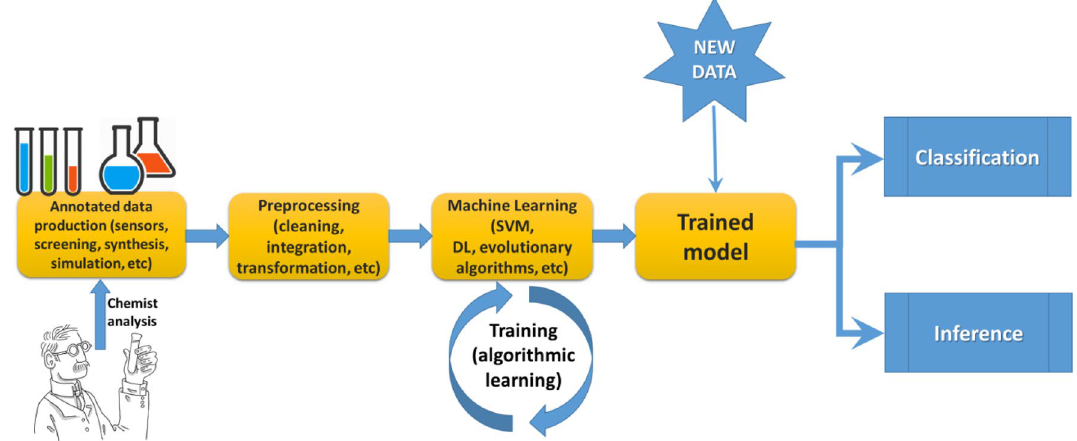
Fig. 2 The standard flow path of ML, from data production to classification or inference. Elaborated by the authors of this